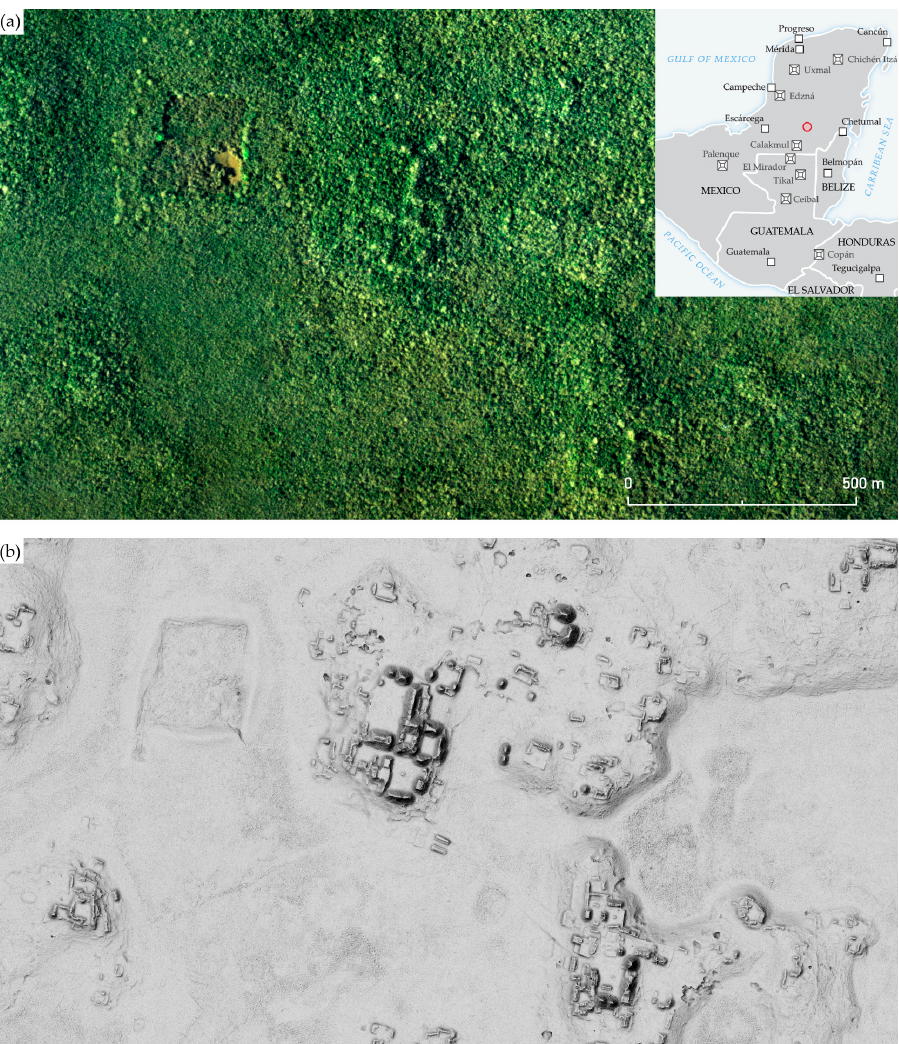
Figure 2. The Maya city of Chactún as seen on ( a ) an orthophoto image (CONABIO 1995–1996) and ( b ) a visualization for archaeological topography. As well as a number of plazas surrounded by temple pyramids, massive palace-like buildings, and two ball-courts, also visible on (b) are quarries, water reservoirs, and sacbeob (raised paved roads). The area is entirely covered by forest, the exploitation of which ceased when the Biosphere Reserve was declared in 1989.